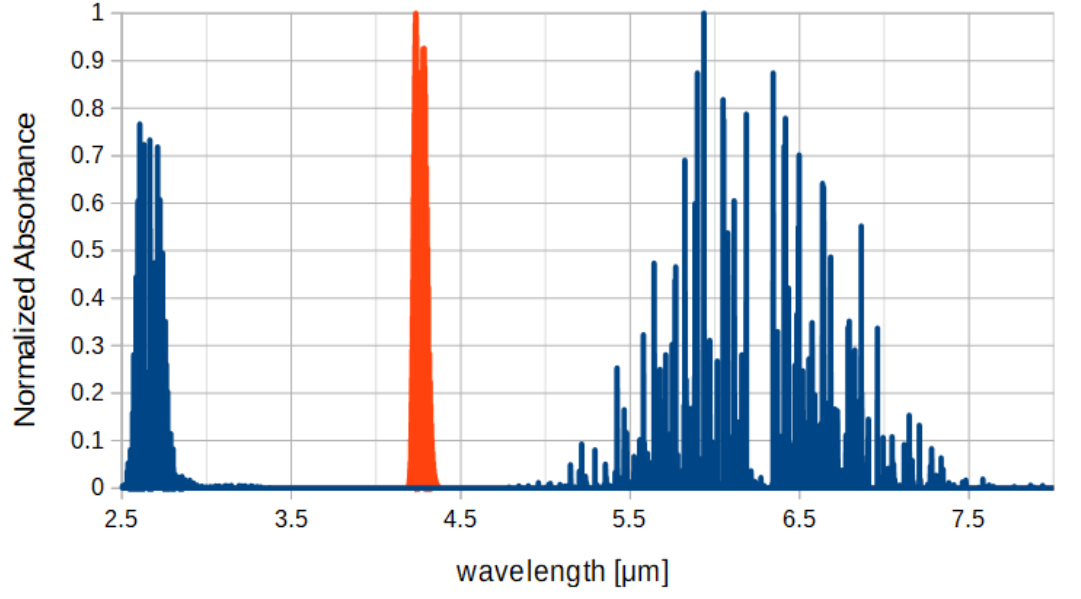
Figure 1. Absorption bands of CO 2 (orange) and H 2 O (blue)